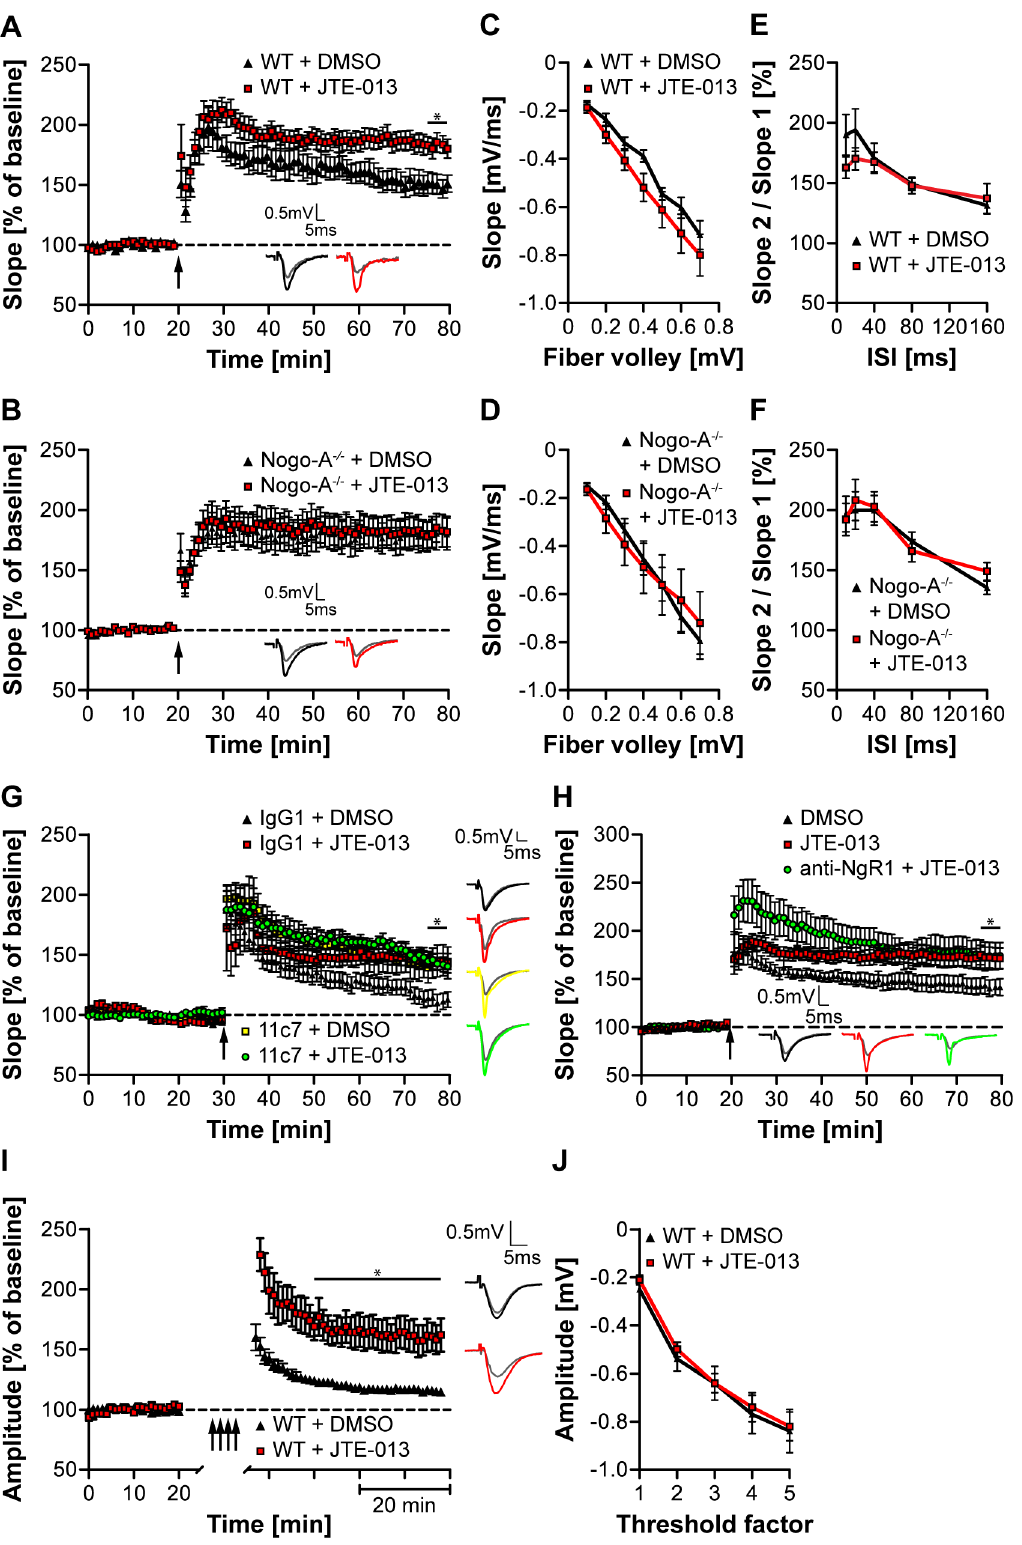
Figure 6. Blockade of S1PR2 phenocopies the increase in hippocampal and cortical LTP observed upon Nogo-A neutralization. (A,B) Hippocampal WT (A) and Nogo-A 2 / 2 (B) slices were treated with JTE-013 or vehicle (DMSO) (WT DMSO : n =8; Nogo-A 2 / 2 DMSO : n =10; WT JTE-013 : n =11; Nogo-A 2 / 2 JTE-013 : n =9). 60 min after theta-burst stimulation (arrow), a significant difference in LTP could be observed between JTE-013 and DMSO treatment in WT (A) but not Nogo-A 2 / 2 (B) slices. (C,D) Input-output strength revealed no differences in JTE-013- versus DMSO-treated slices of WT (C) and Nogo-A 2 / 2 (D) mice (WT DMSO : n =6; Nogo-A 2 / 2 DMSO : n =6; WT JTE-013 : n =7; Nogo-A 2 / 2 JTE-013 : n =6). (E,F) PPF revealed no alterations in